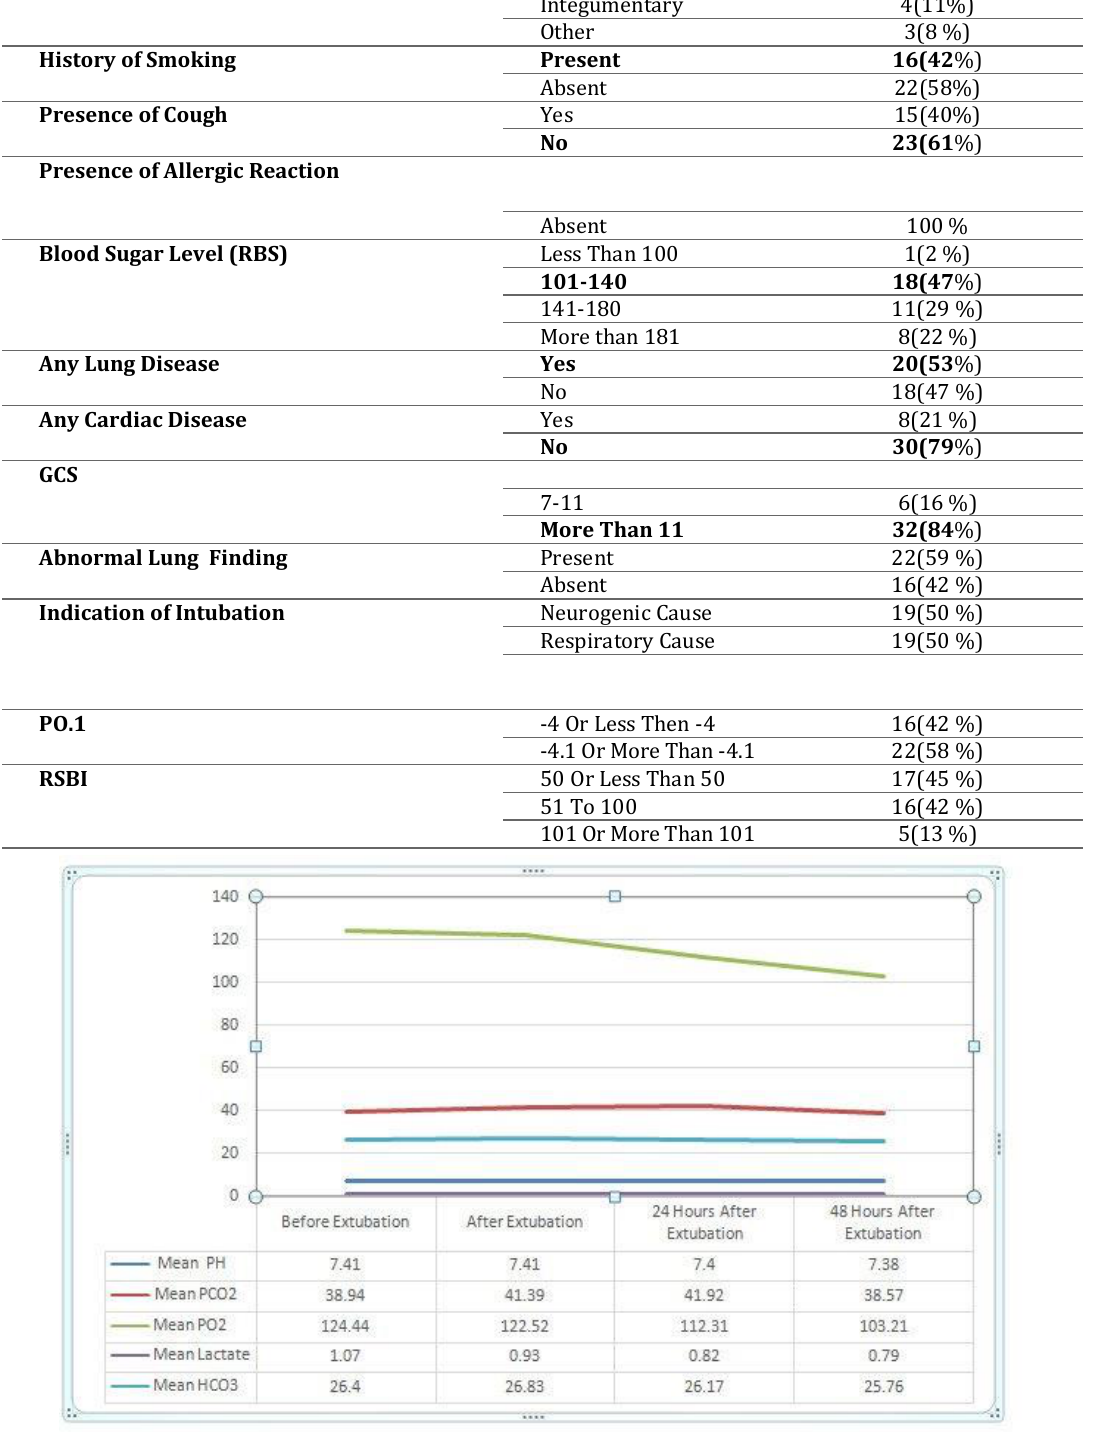
Graph 1 . Arterial Blood Gas analysis of Pre & Post Extubated